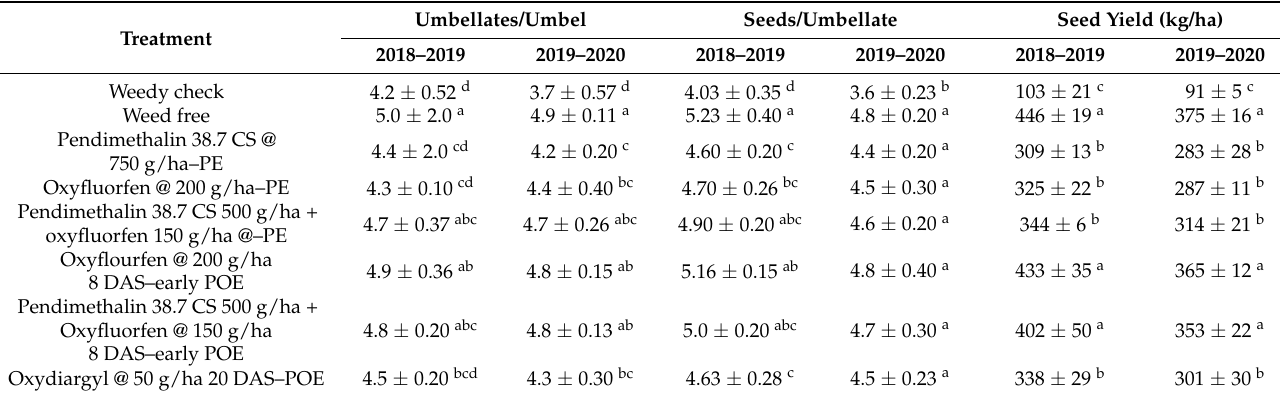
Table 2. Effect of herbicidal weed management on yield and yield attributes of